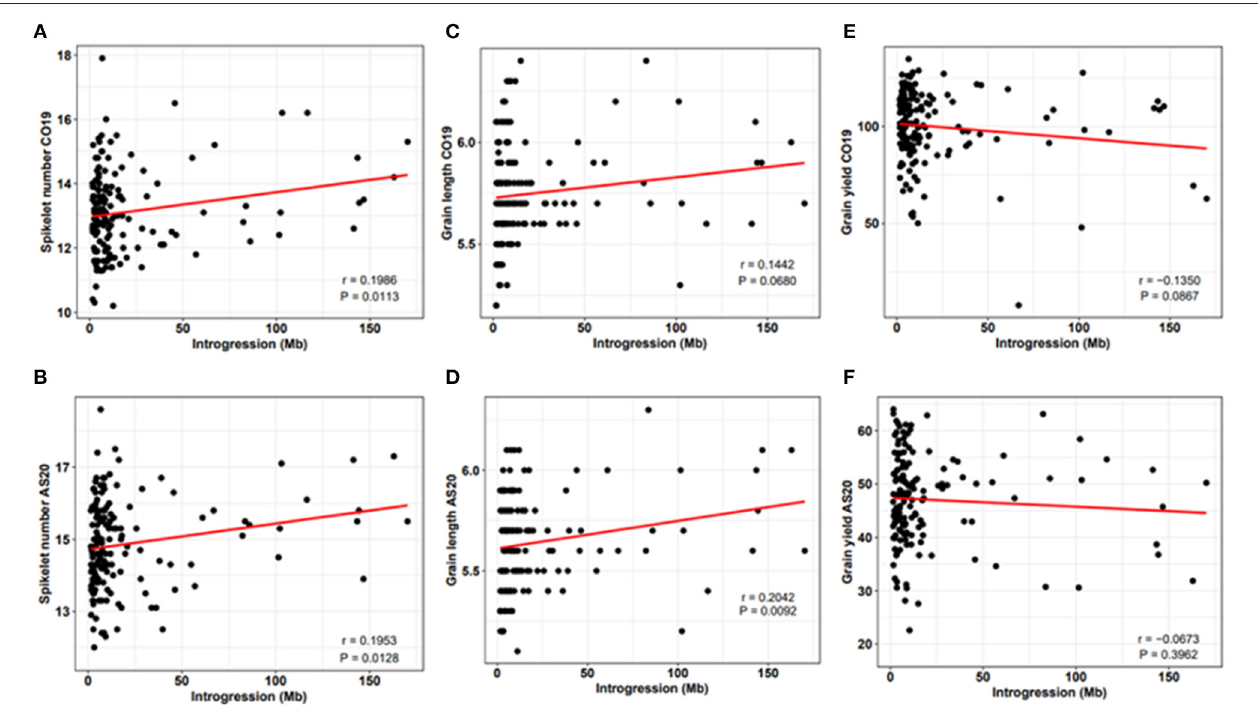
FIGURE 3 | Relationship between SNS (A,B) , GL (C,D) , GY (E,F) , and the proportion of introgression under non-irrigated conditions at Colby in 2019 (CO19) and Ashland in 2020 (AS20). Here, r is the correlation coefficient and P is the significance of the correlation between introgression size and observed trait phenotype.